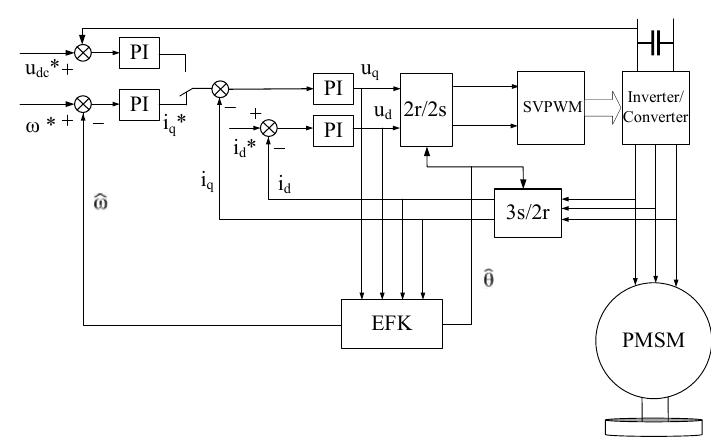
Fig. 16. FESS charging and discharging control block diagram based on